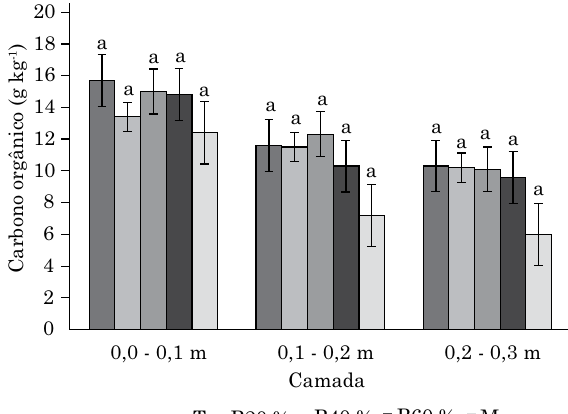
Figura 4. Teores de carbono orgânico, com os erros da média, para as áreas sob cultivo de figo e mata secundária (T - Testemunha; B20 % - Biofertilizante 20 %; B40 % - Biofertilizante 40 %; B60 % - Biofertilizante 60 %; e M - Mata nativa). médias seguidas pela mesma letra na camada não diferem pelo teste de Dunnett (p≤0,05).